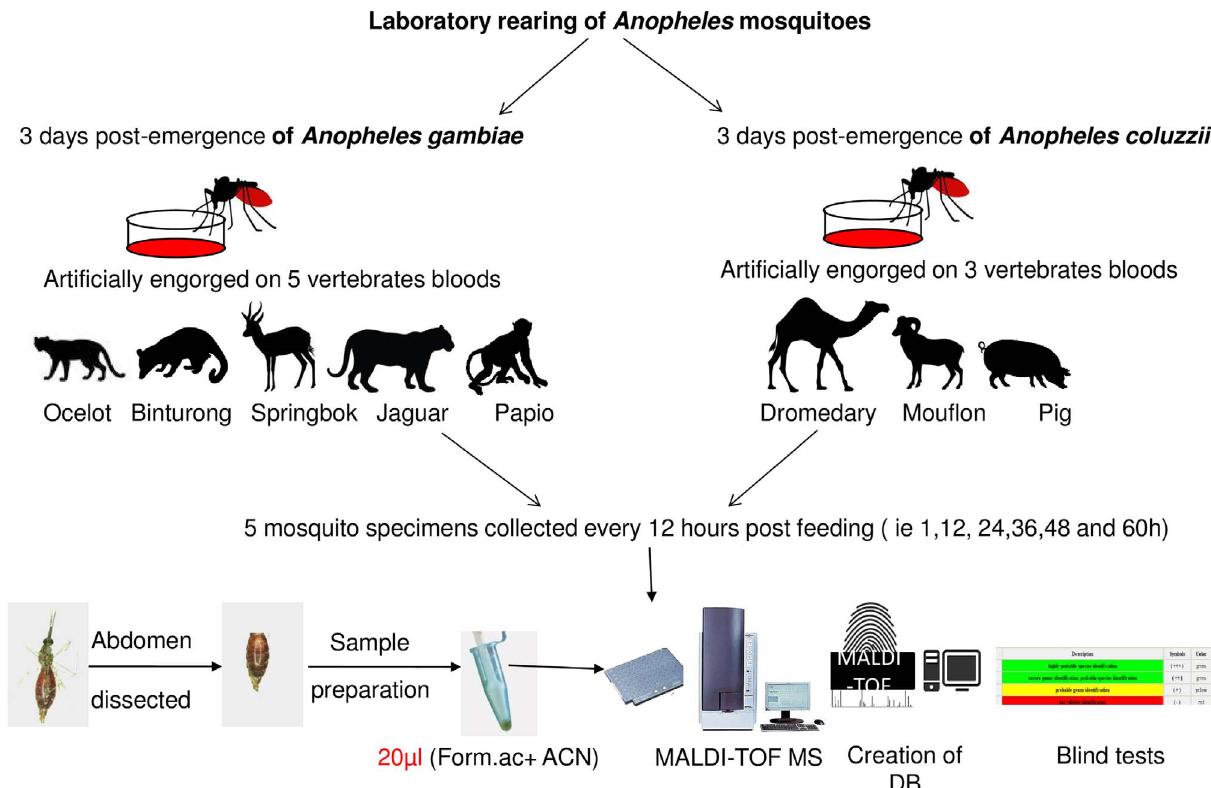
Figure 1. Experimental workflow for blood meal identification using MALDI-TOF MS (Form.ac: Formic acid; ACN: acetonitrile; DB: